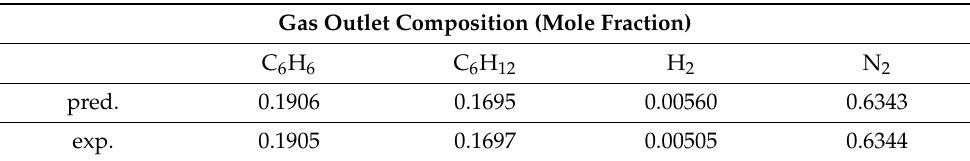
Table 1. Verification of the model with experimental data from the unit tube; gas outlet composition after 40 days of operation period